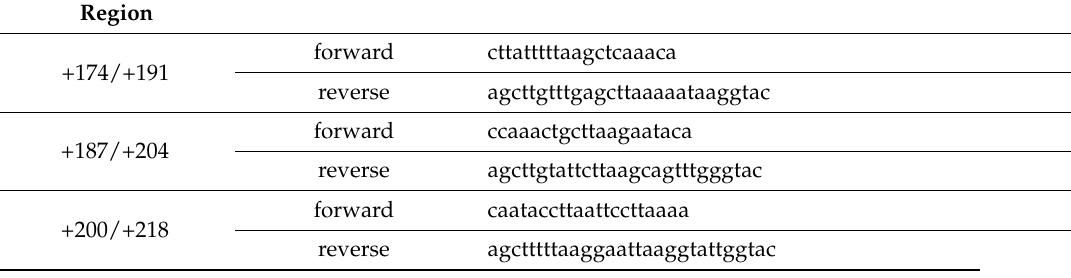
Table A3. Partial TXNIP promoter (+174/+218) sequence of oligonucleotide for annealing. Region